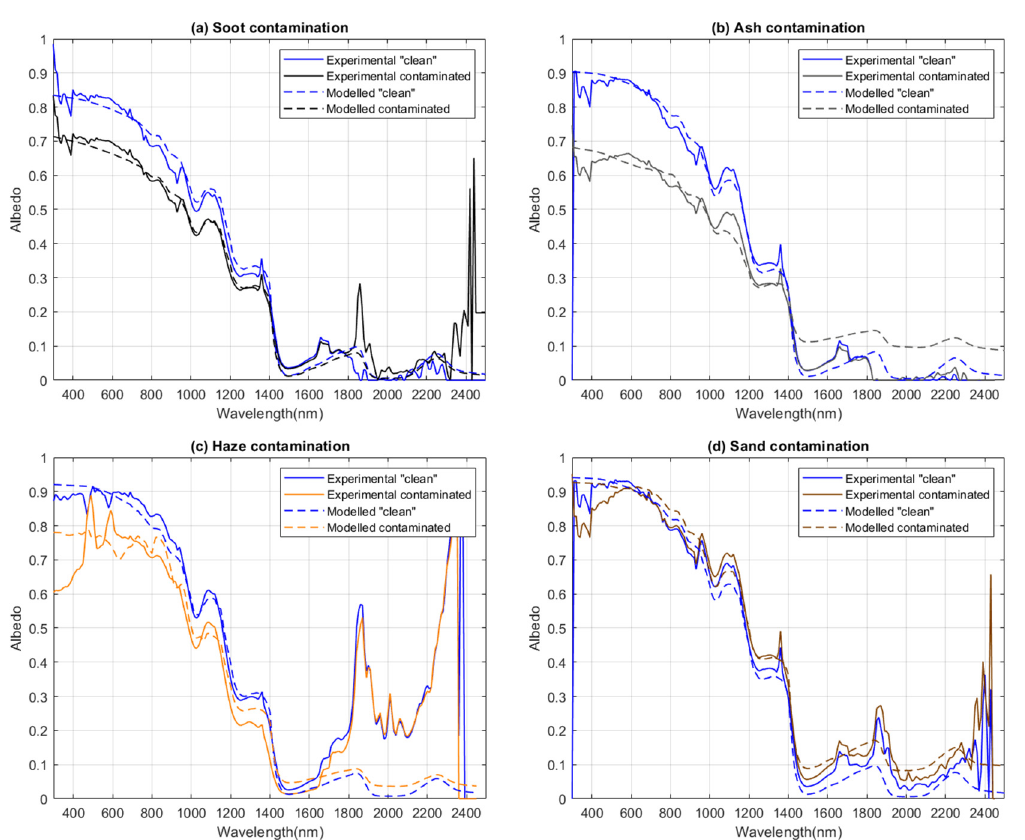
Figure 10. Experimental results of snow albedo contaminated with soot ( a ), ash ( b ), haze ( c ), and sand ( d ). Straight lines correspond to experimental snow albedo and dashed lines to modelled albedo. Blue lines correspond to “clean” snow albedo.